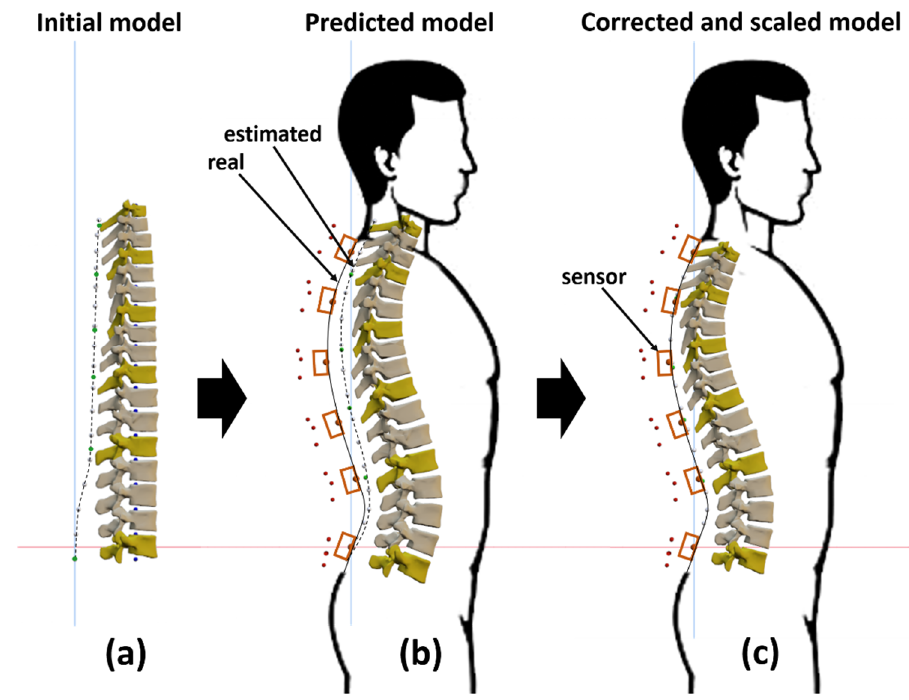
Figure 5. Posture determination process: ( a ) initial model; ( b ) predicted model; ( c ) corrected and scaled model.